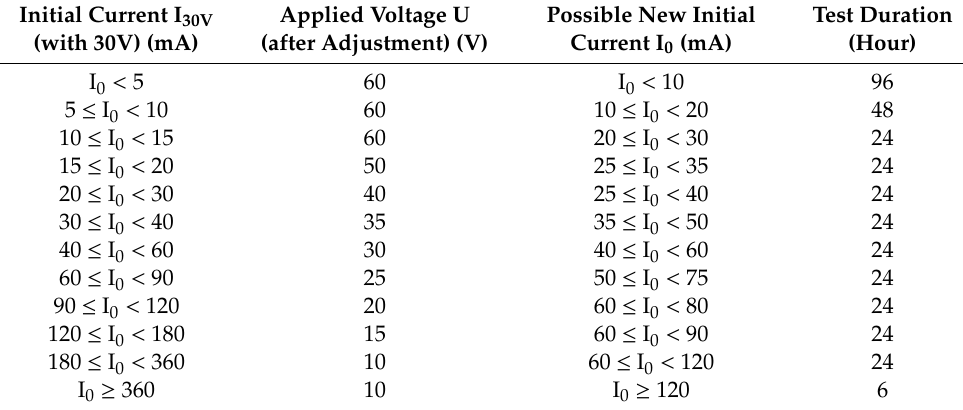
Figure 4. Schematic diagram of electrochemical impedance spectroscopy (EIS) experiment. Table 3. Test voltage and duration for concrete specimen with normal binder content [45].